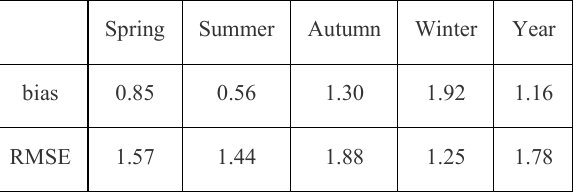
Table 1. ZTD bias and RMSE changes (cm)